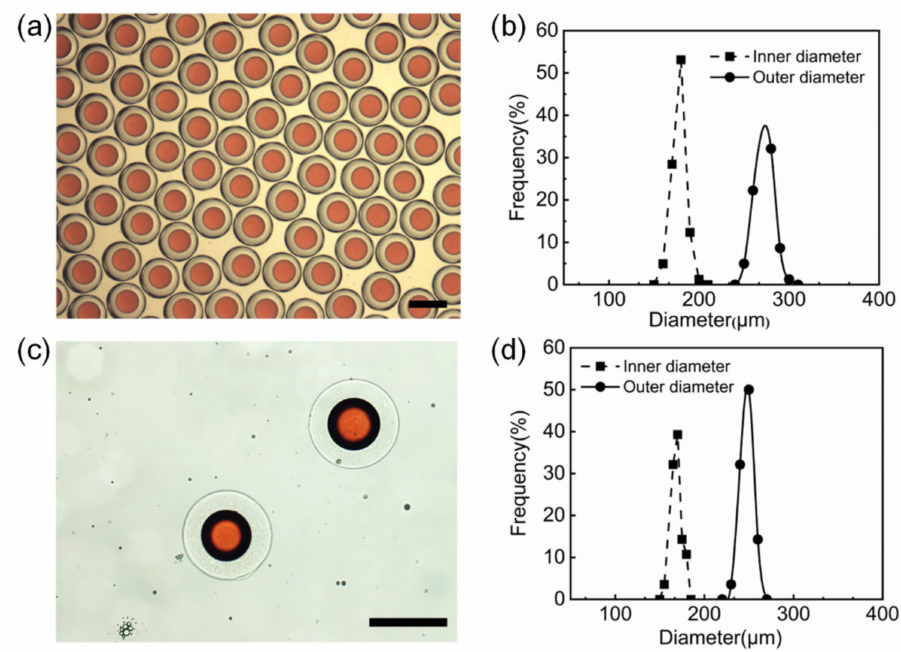
Figure 7. Preparation of microcapsules with micro-mixer by on-line mixing. Optical micrographs ( a ) and the size distribution of O/W/O emulsions ( b ). The resultant alginate microcapsules 1% ( w / v ) CaCl 2 solution ( c ) and the corresponding size distribution ( d ). Scale bars are 200 µ